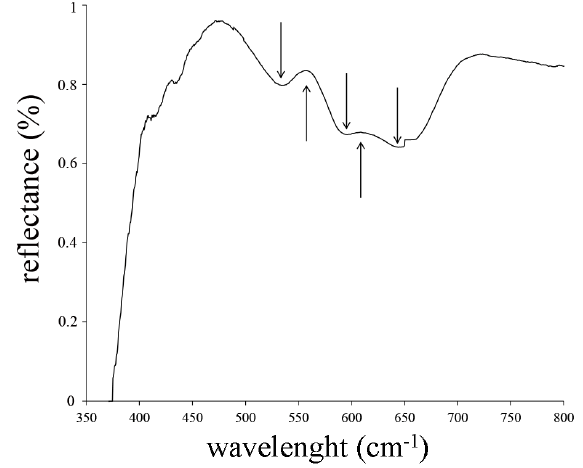
Figure 6. FORS spectrum of the azure tessera TN AZ1, showing maximum reflectance at 550 and 625 nm and a minimum of reflectance at 525, 600 and 650 nm [52], in accordance with the presence of cobalt in the visible interval. Similar spectra are obtained for grey tesserae.